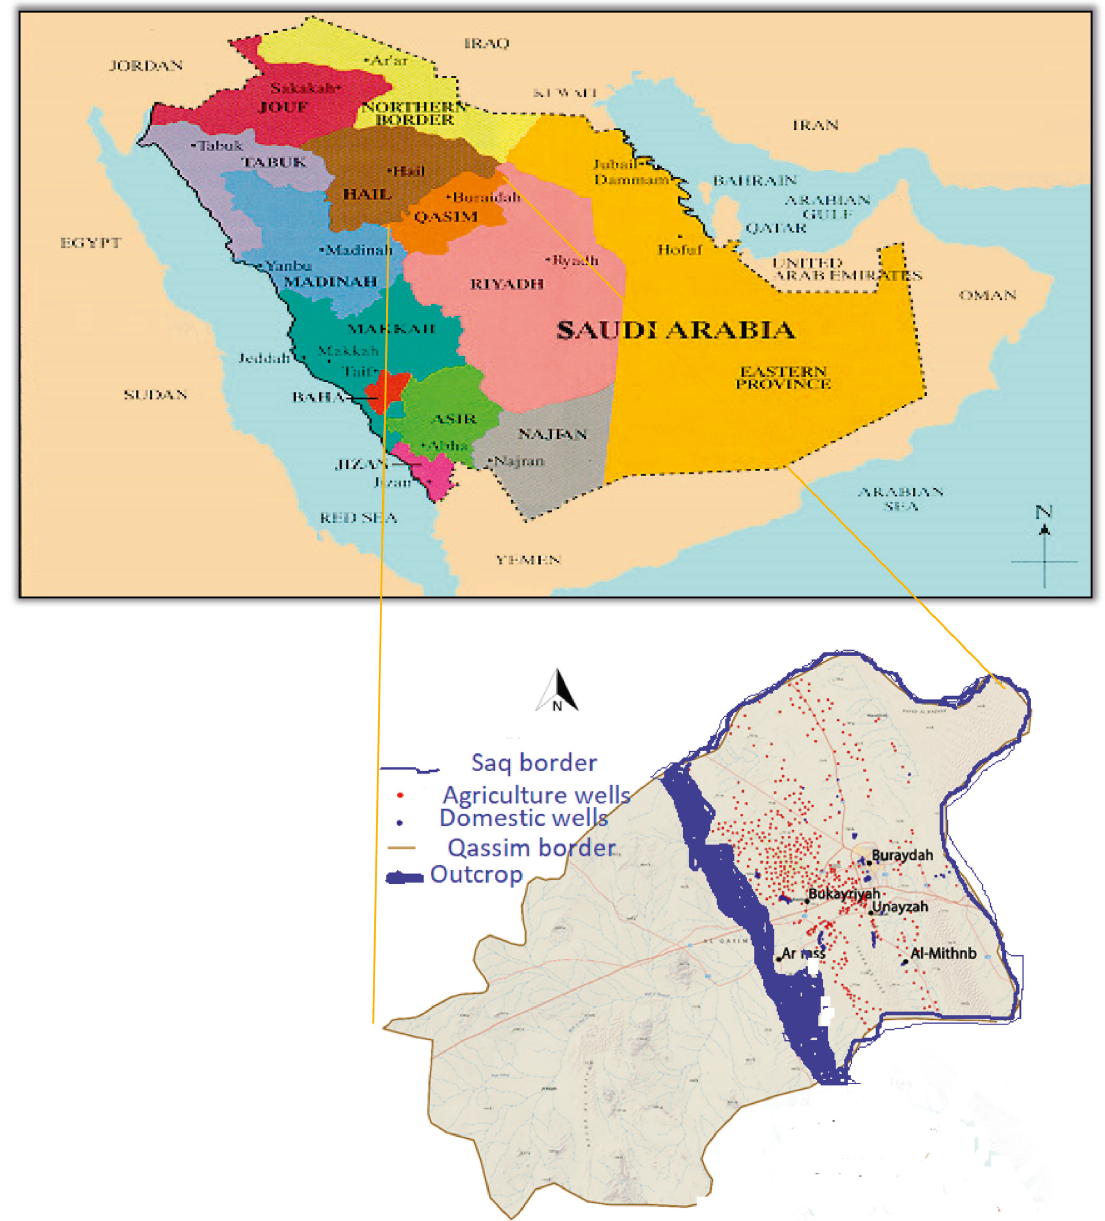
Figure 3: Map of the study area showing the locations of pumping wells, Saq in the Qassim Region, and Saq